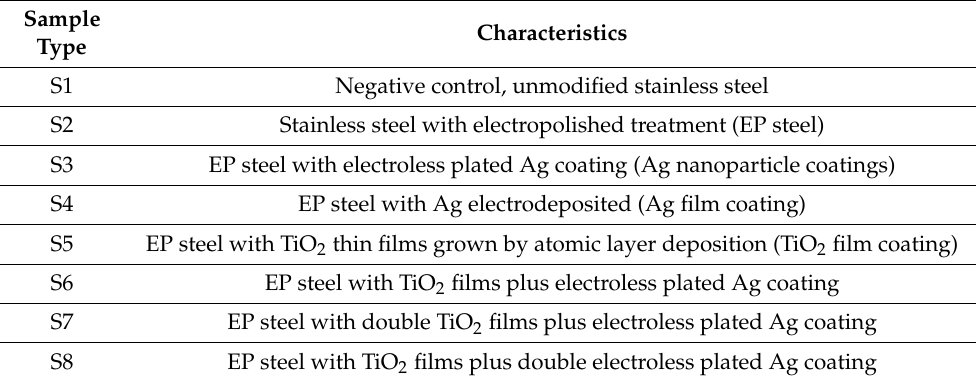
Table 3. Sample type employed for the different antibiofilm